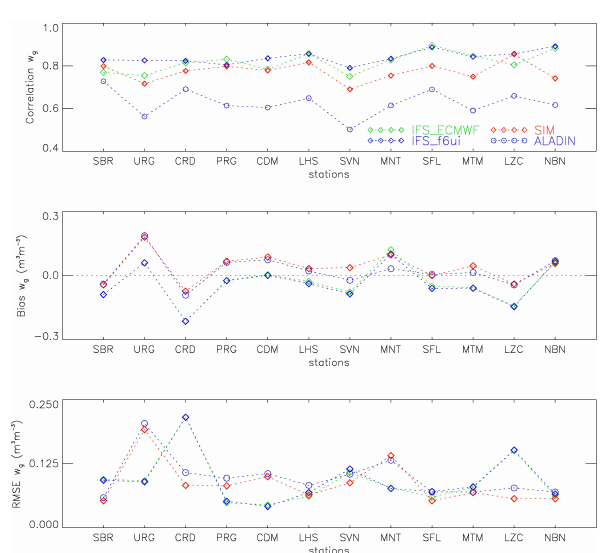
(Table 6). The average r between the IFS ECMWF root-